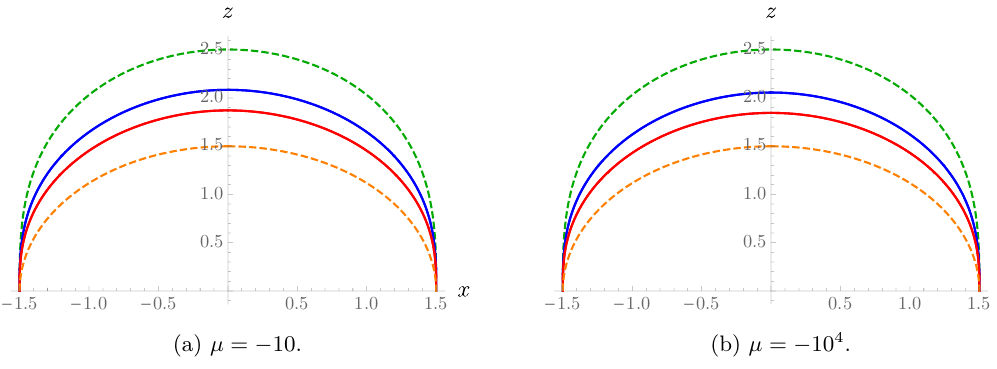
Figure 5 . Causal surface (orange, dashed) and entanglement surfaces corresponding to ECG in the case of minimal prescription (blue), ECG in the case of non-minimal prescription (red), and Einstein gravity (green, dashed) [35] for the boundary strip length ‘/ 2 = 1 . 5 and different values of µ outside the interval − 0 . 00322 ≤ µ ≤ 0 . 00312 . In both cases, we verify that z for both